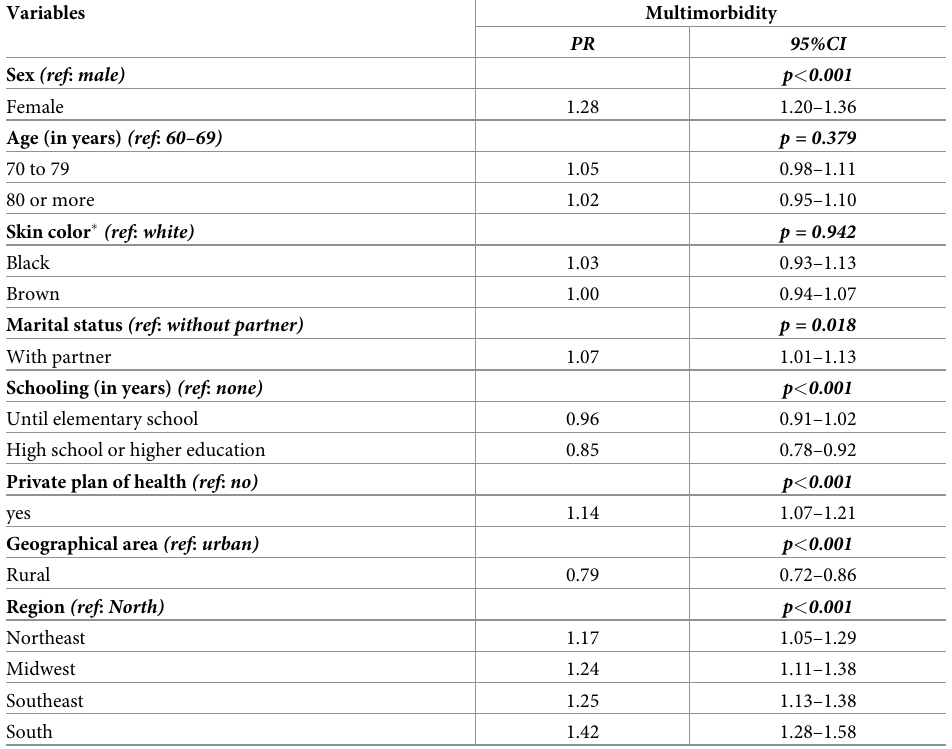
Table 2. Adjusted analysis between prevalence of multimorbidity and independent variables in Brazilian older adults. National Health Survey (PNS-Brazil, 2013), n = 11,177. Variables Multimorbidity PR